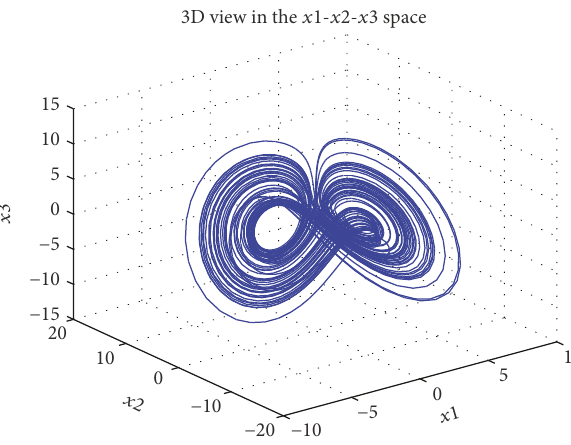
Figure 1: The chaotic attractor of the financial system